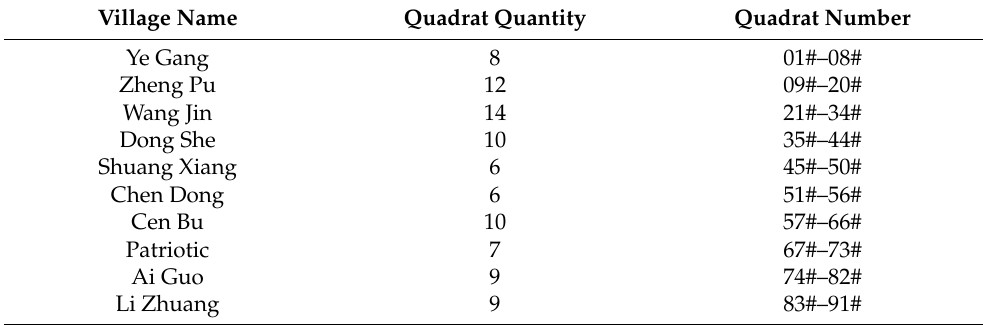
Table 1. Statistical table of quadrat selection of rural rivers in Qingxi area of Shanghai (source: author. Village